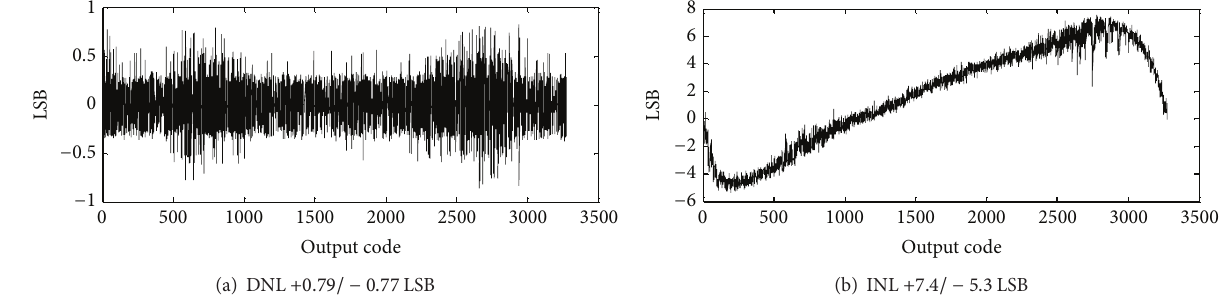
Figure 15: Measured ADC DNL (a) and INL (b).